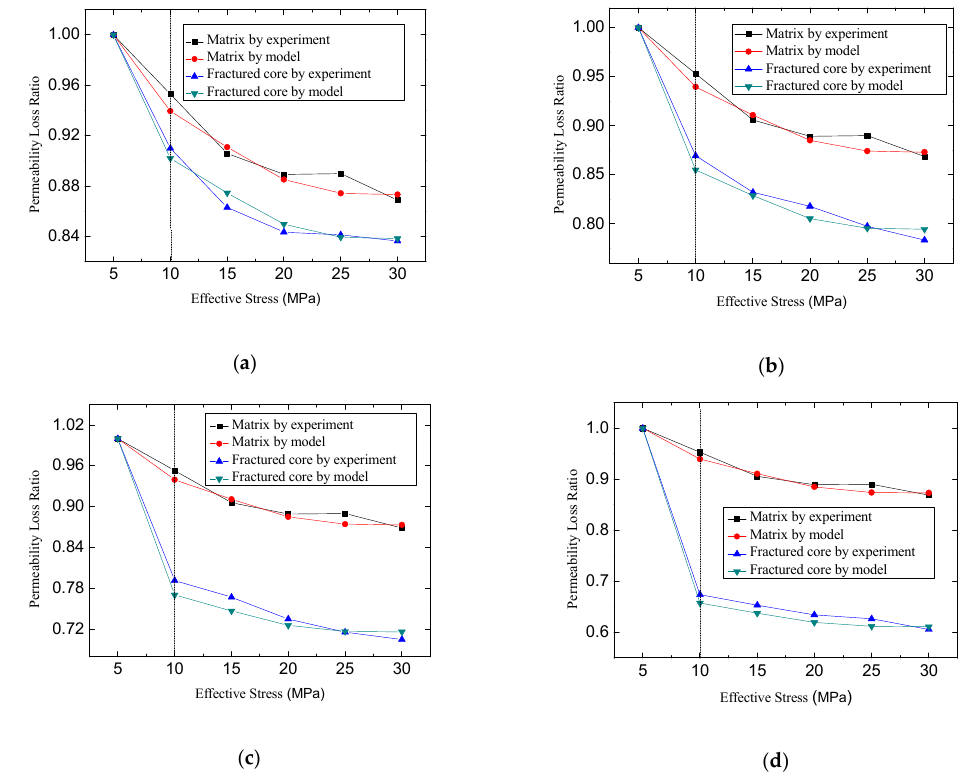
Figure 8. Comparison curve for the experimental data and model results. Core with (a) 25%, (b) 50%, (c) 75%, and (d) 100% penetration.